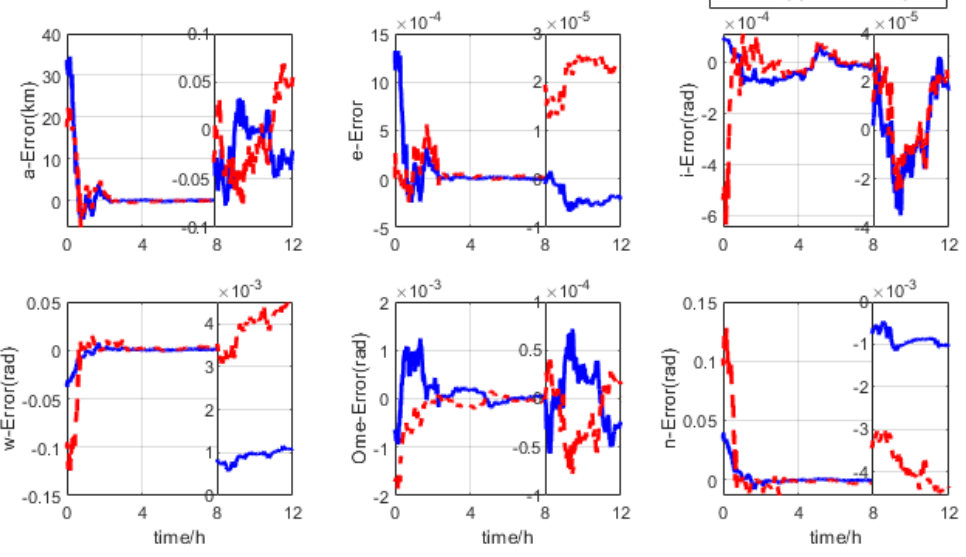
Figure 3. Estimation errors of orbit elements in general case .